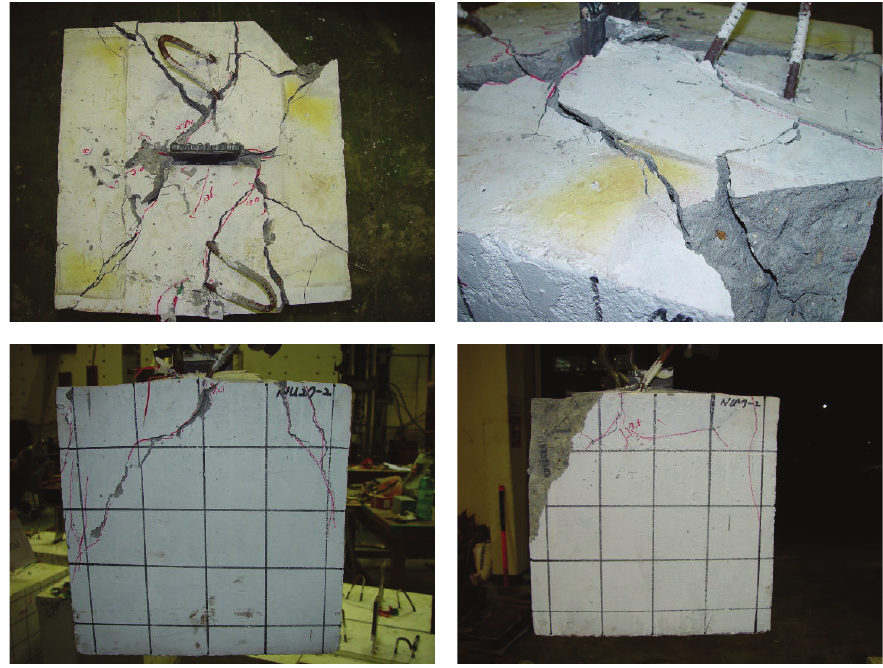
Figure 11: Failure mode of specimen PU-5027-R (Type